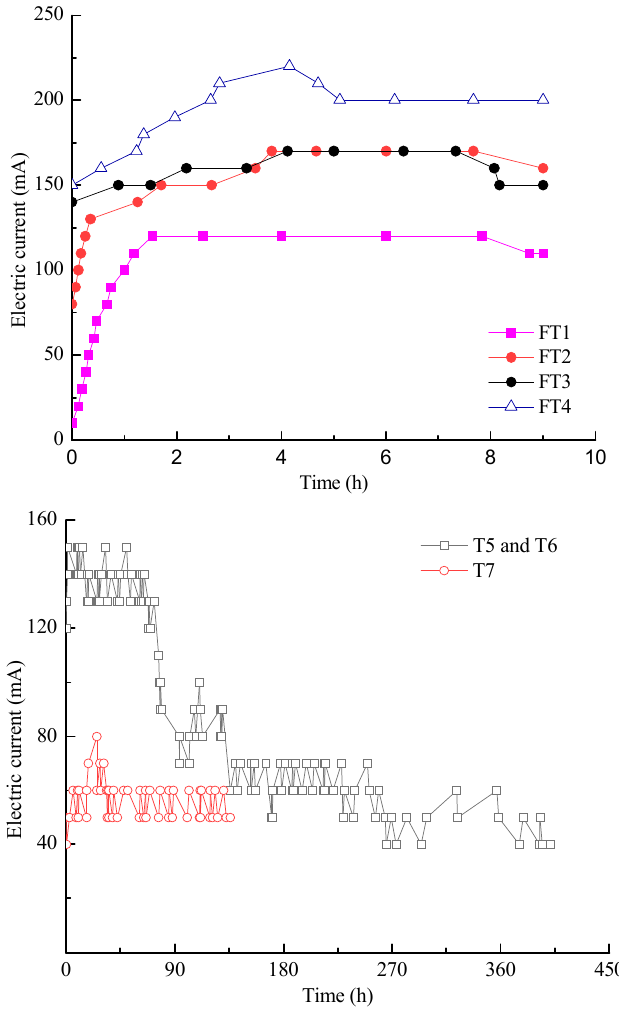
Figure 5. Electric current variation during EKR treatment.